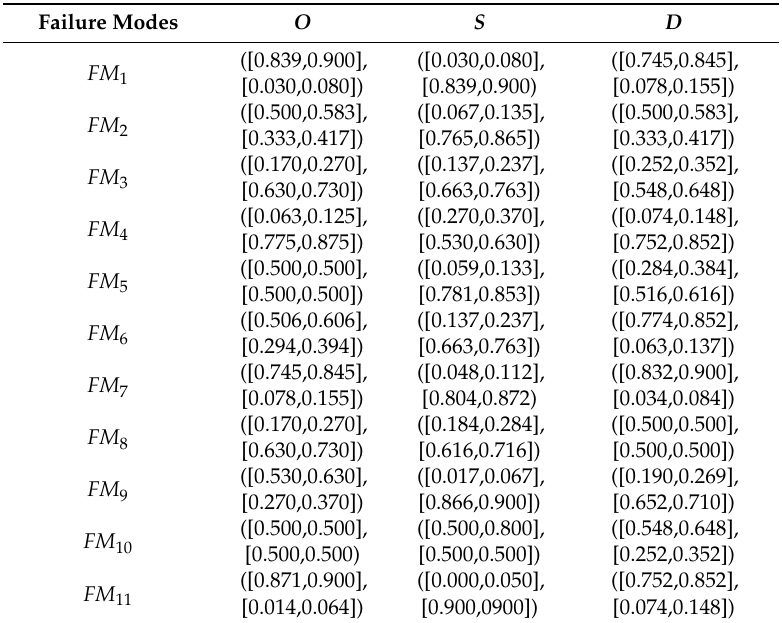
Table 4. Interval-valued intuitionistic fuzzy comprehensive evaluation matrix.